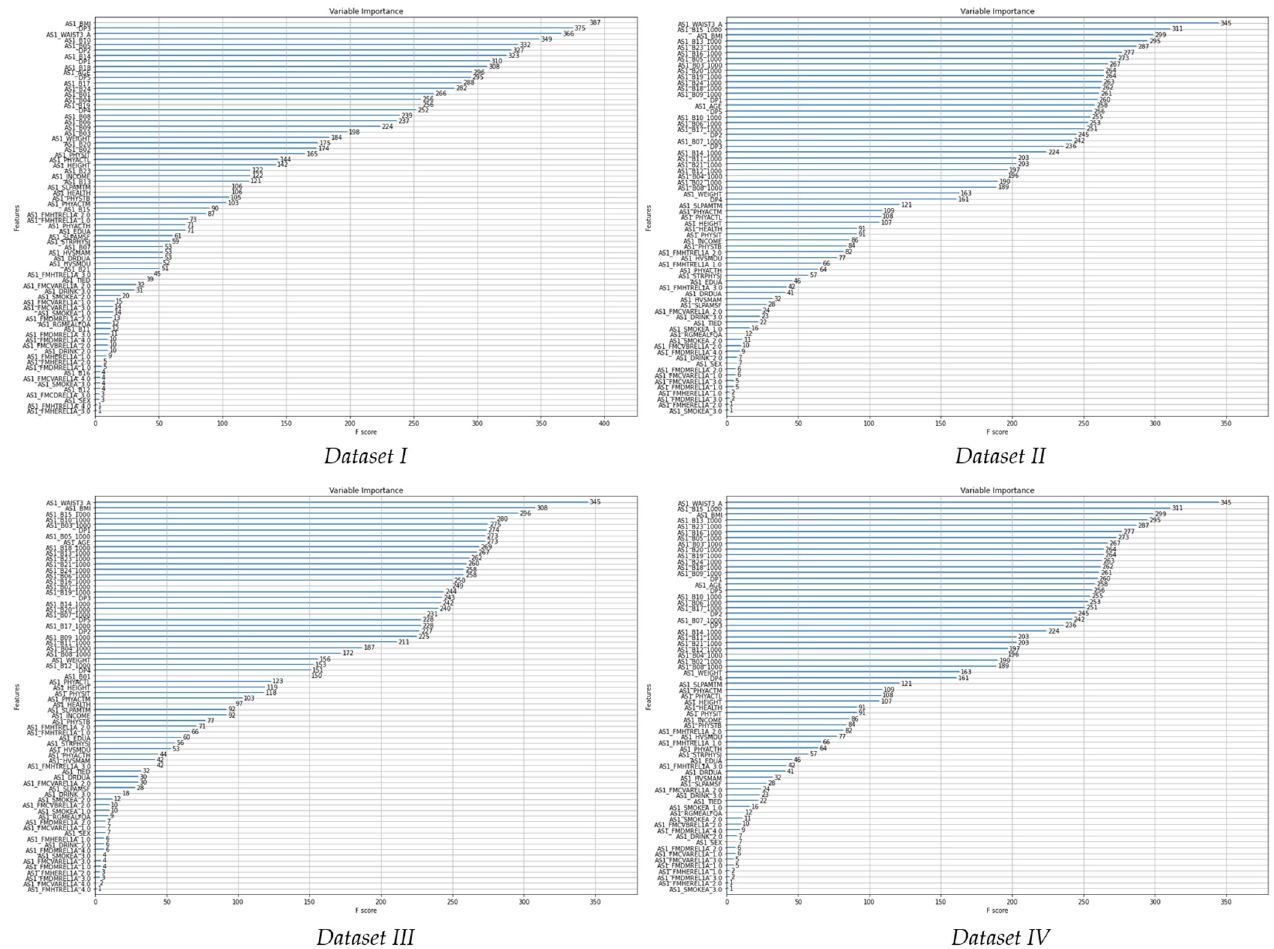
Figure 3. Decision tree for variable importance. AS1_age, age; AS1_BMI, BMI; AS1_B01, energy;